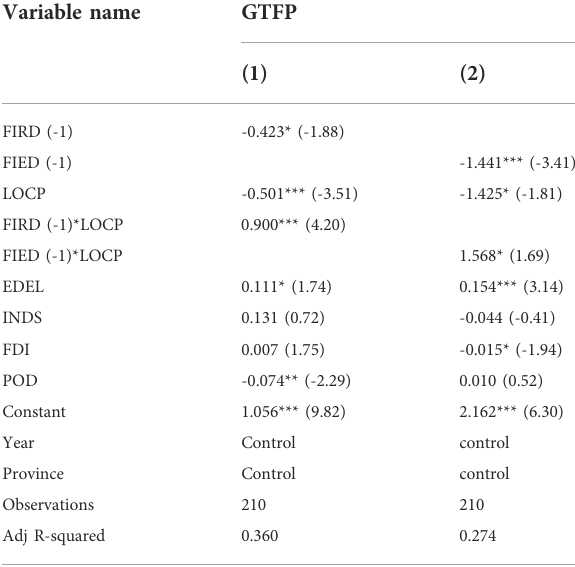
TABLE 7 Results of mechanism